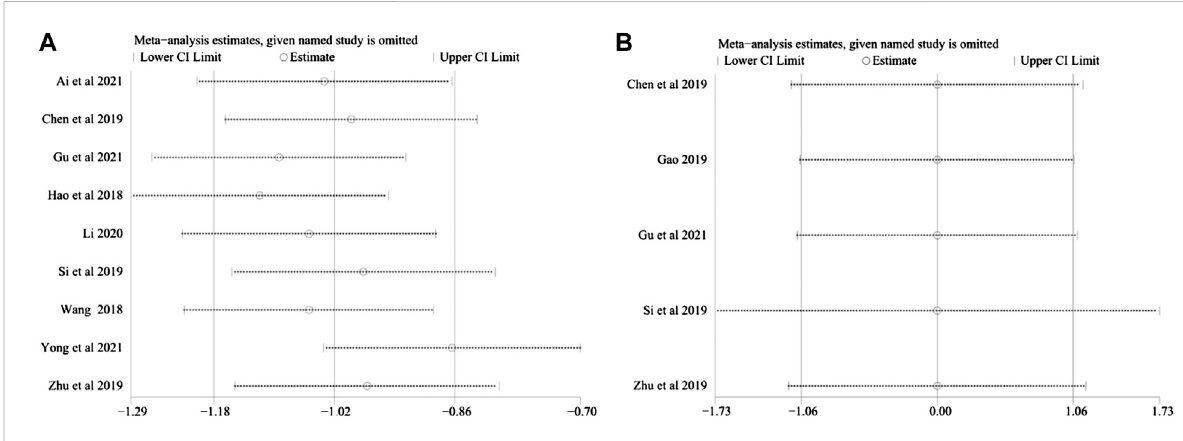
FIGURE 10 (A) Sensitivity analysis plots of total CRF dichotomous variable scores. (B) Sensitivity analysis plots of QLQ-C30.